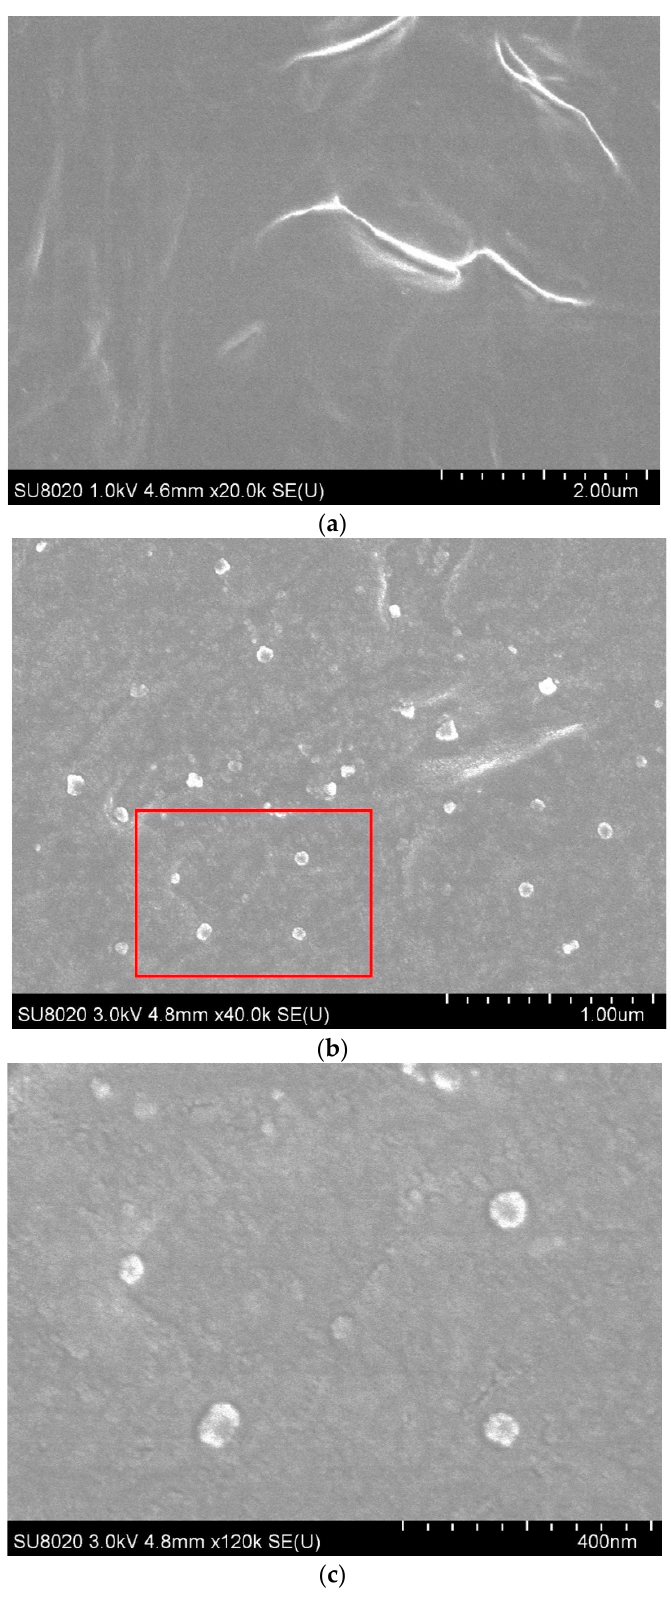
Figure 5. SEM image of the pure LDPE ( a ) and LDPE-g-PS/DPE composite ( b ). The SEM image in ( c ) shows the topography in the red box in ( b ).